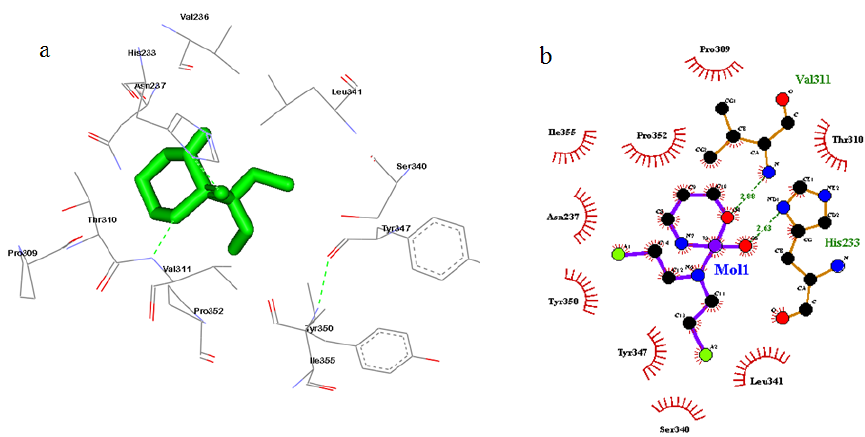
Figure 5. Molecular docking showed strong hydrophobic interaction and hydrogen bonding in “DM- Cyclin A2” ( a ) Interaction of Dimethoate with cyclin A2. The ligand (Dimethoate) has been shown in “stick” representation. ( b ) “Ligplot” of Figure 5a showing bonding interactions.